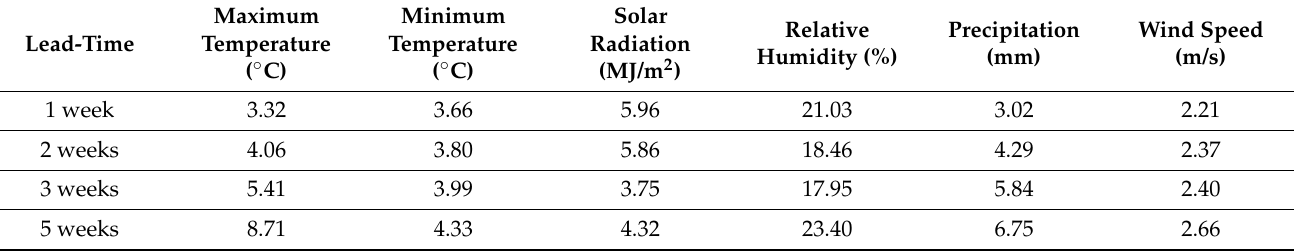
Table 2. RMSE of weather variables at various lead